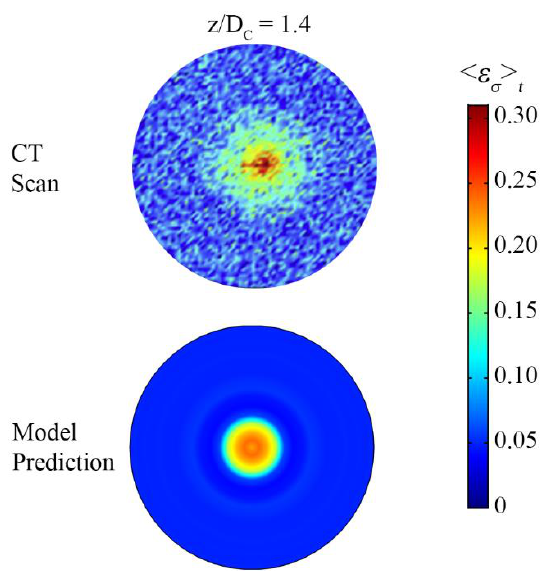
Figure 9. Comparison between CT scan results and model prediction of the time averaged cross- Figure9. ComparisonbetweenCTscanresultsandmodelpredictionofthetimeaveragedcross-sectional sectional solids holdup distribution for spouted bed packed with 2 mm glass beads, solids holdup distribution for spouted bed packed with 2 mm glass beads, H σ ,0 = 160 mm and (cid:68) (cid:69) V β / V ms = 1.1 at z / D C = 0